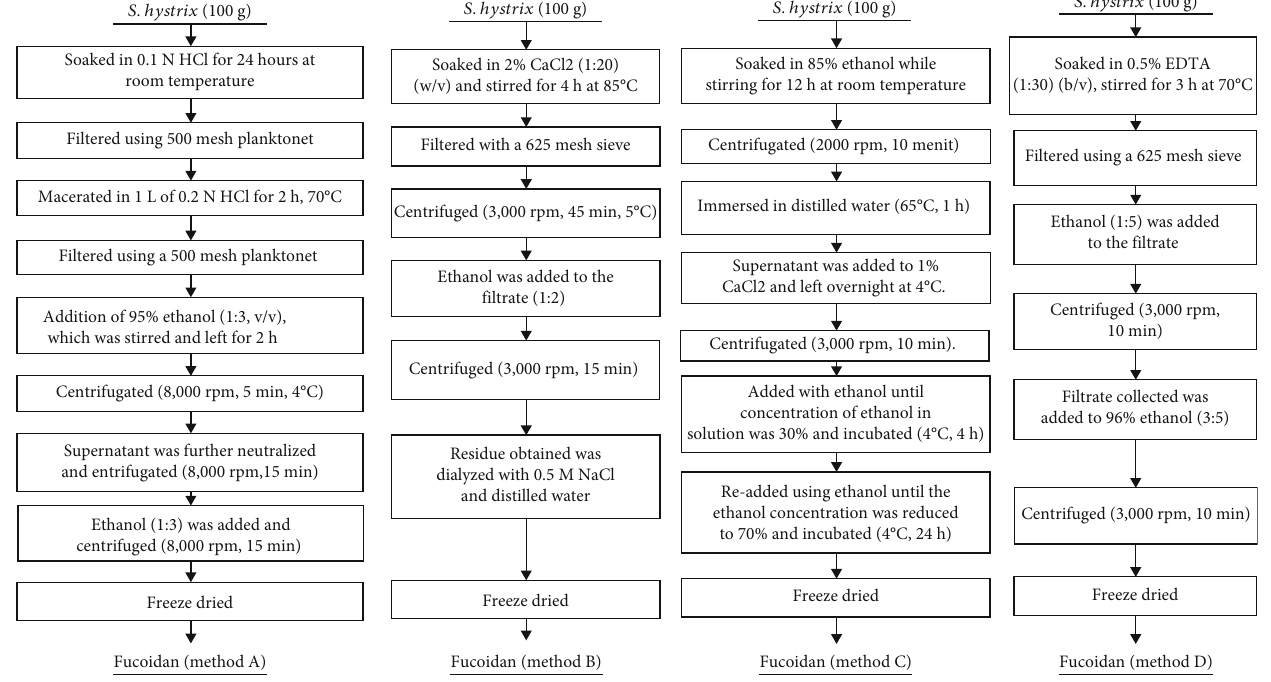
Figure 1: Schematic diagram of four extraction methods of fucoidan from Sargassum